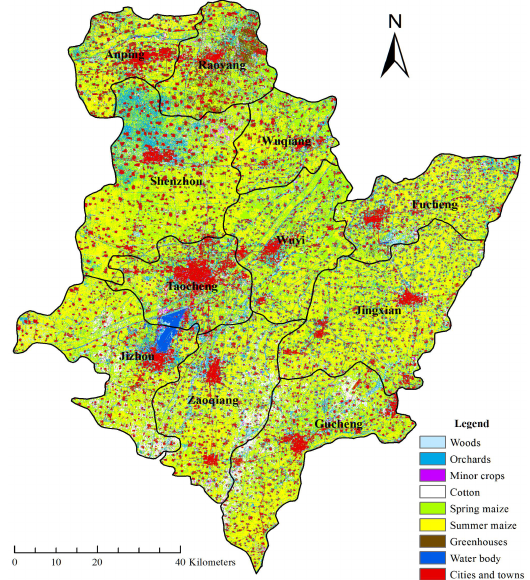
Figure 5. Crop classification results in Hengshui city.